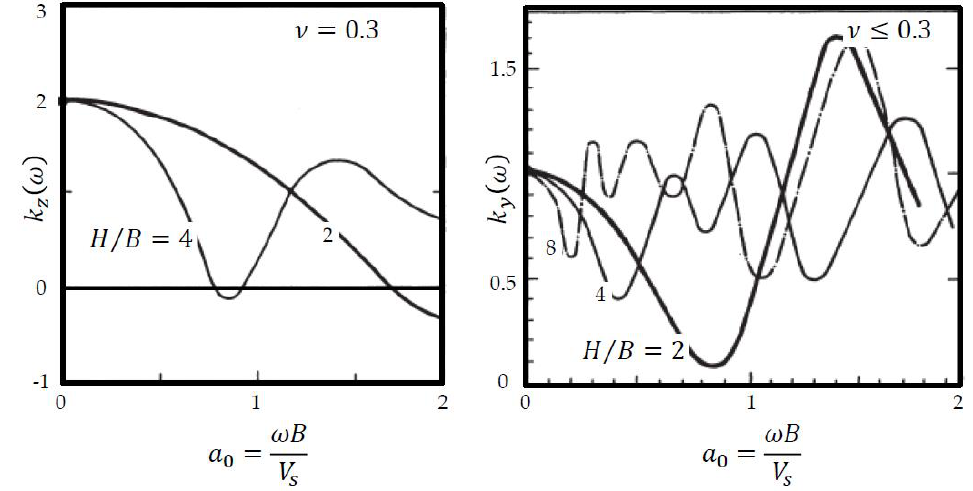
Figure 2. Dynamic coefficients for the calculation of the vertical ( k z ( ω ) ) and lateral ( k y ( ω ) ) stiffness [56].